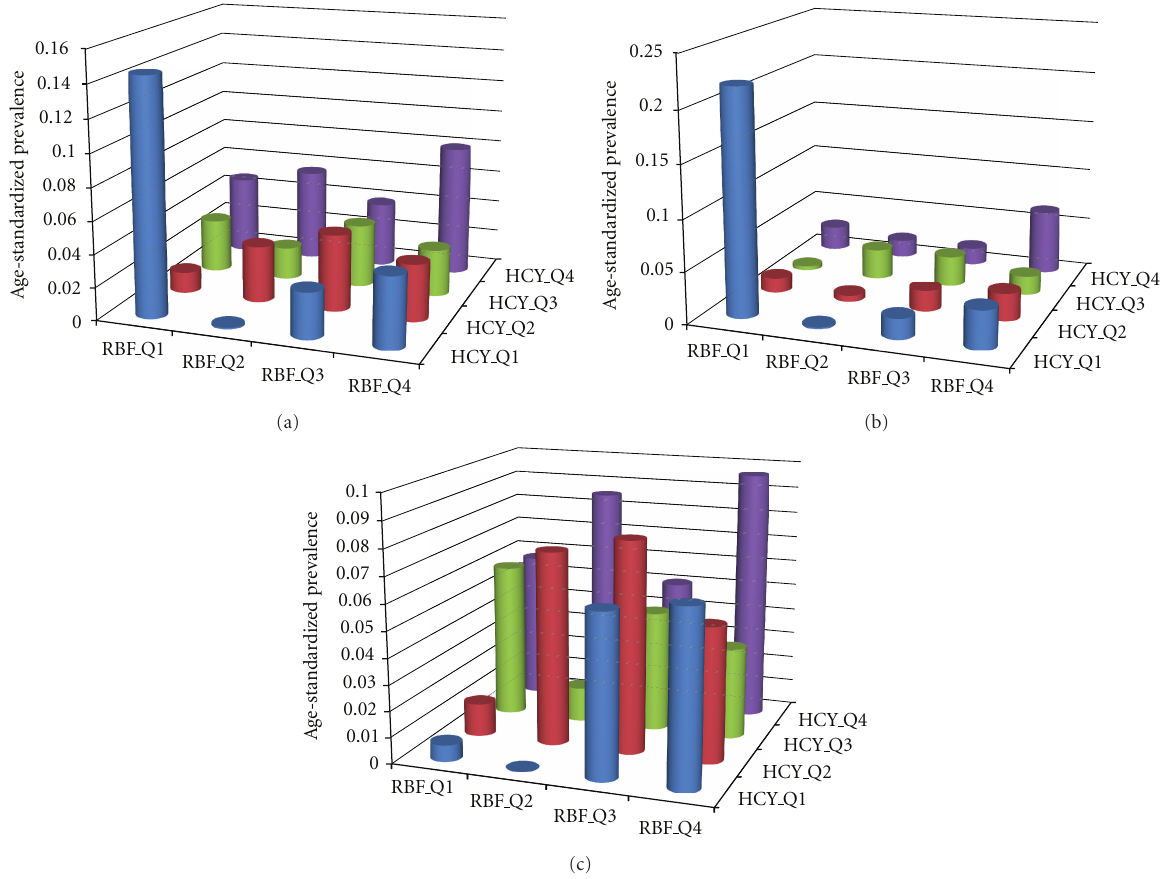
Figure 2: Age-standardized prevalence rates of diagnosed, self-reported sleep apnea based on combinations of quartiles of plasma homocys- teine and RBC folate levels. Plots are for all subjects (a), females only (b), and males only (c). HCY: plasma homocysteine; RBF: RBC folate; Q: quartile.